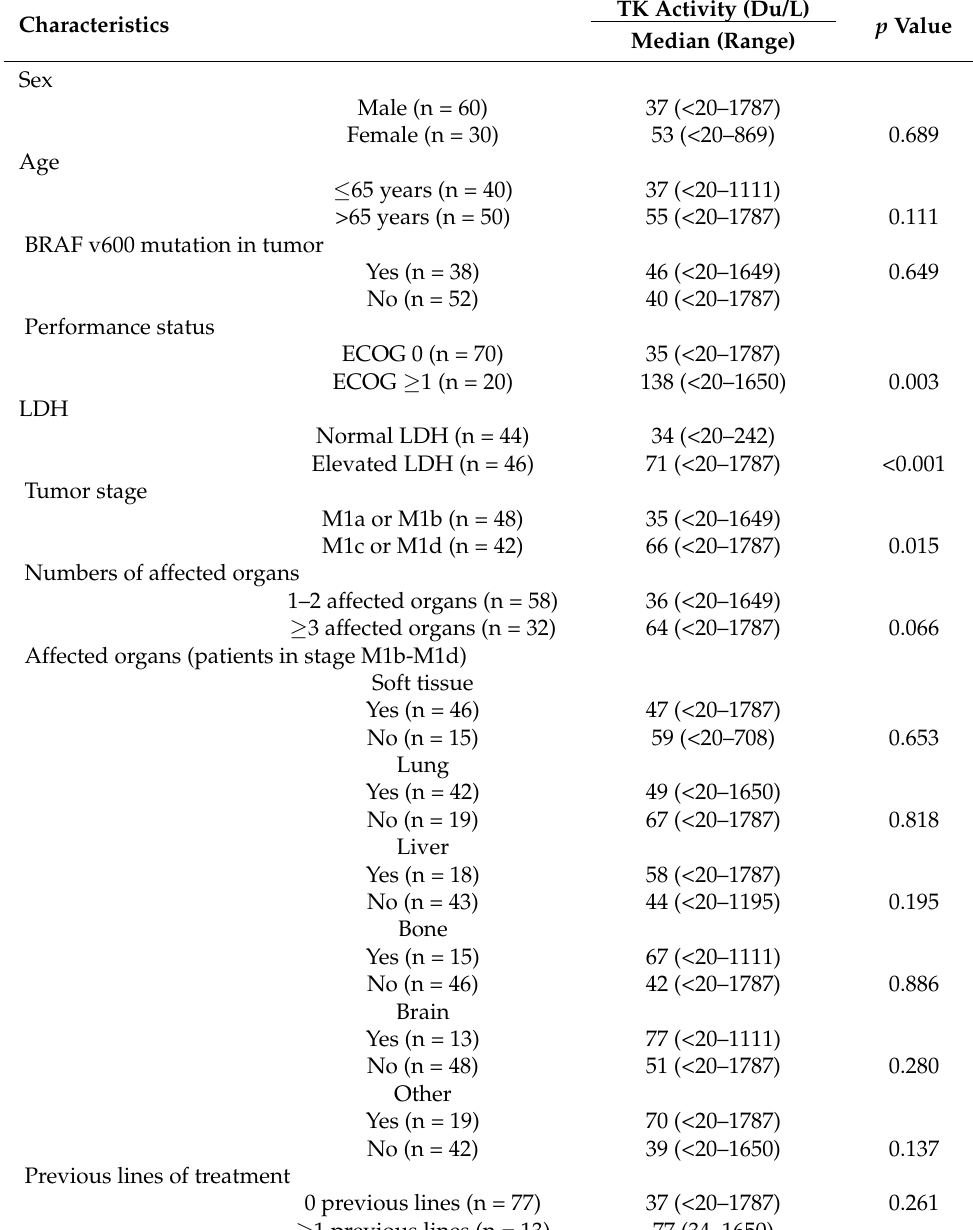
Table 1. Pre-treatment thymidine kinase 1 (TK) activity (Du/L) in the plasma of patients with unresectable